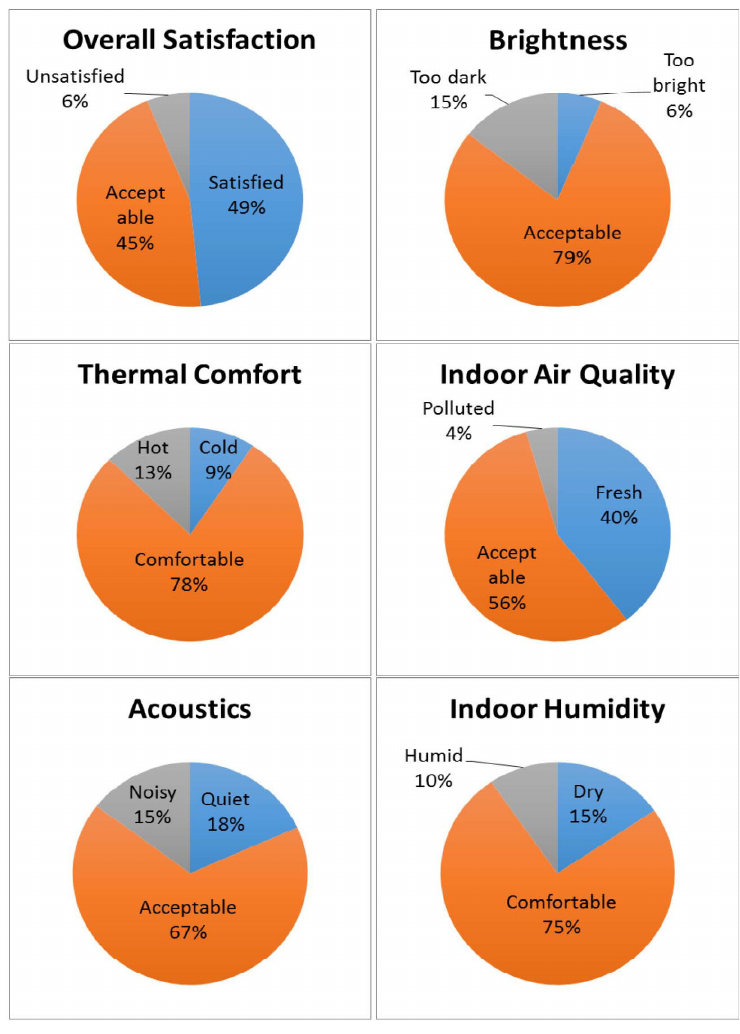
Figure 14. Responses to the occupant survey, April–May